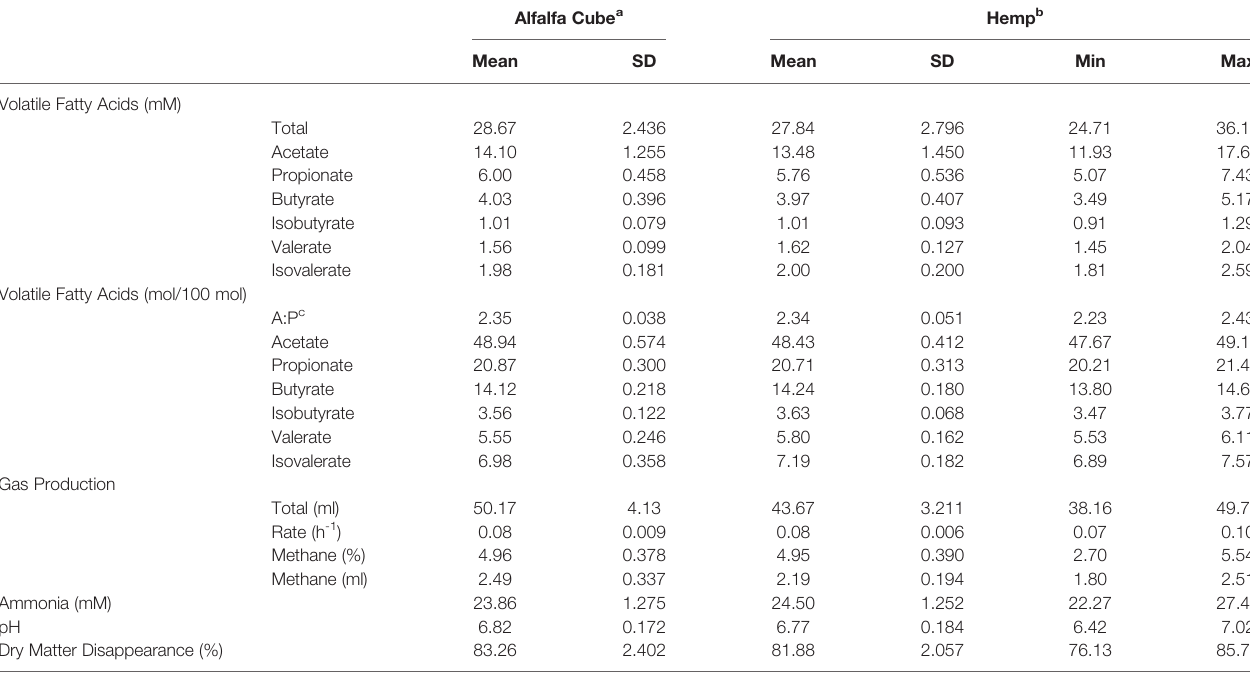
TABLE 5 | Descriptive statistics for in vitro products of digestion of in fl orescence from 9 non-extracted hemp cultivars after 48-h digestion period. Alfalfa Cube